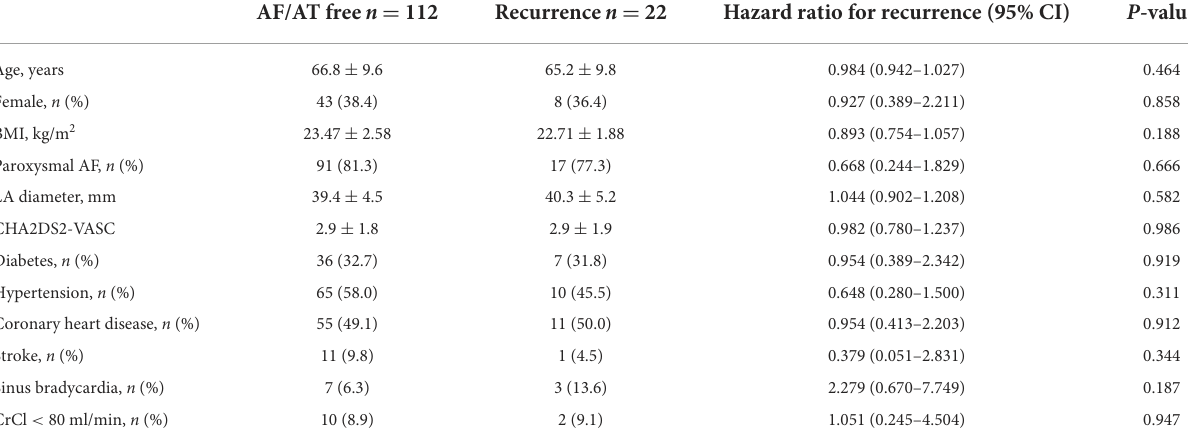
TABLE 3 Clinical characteristics for recurrence.